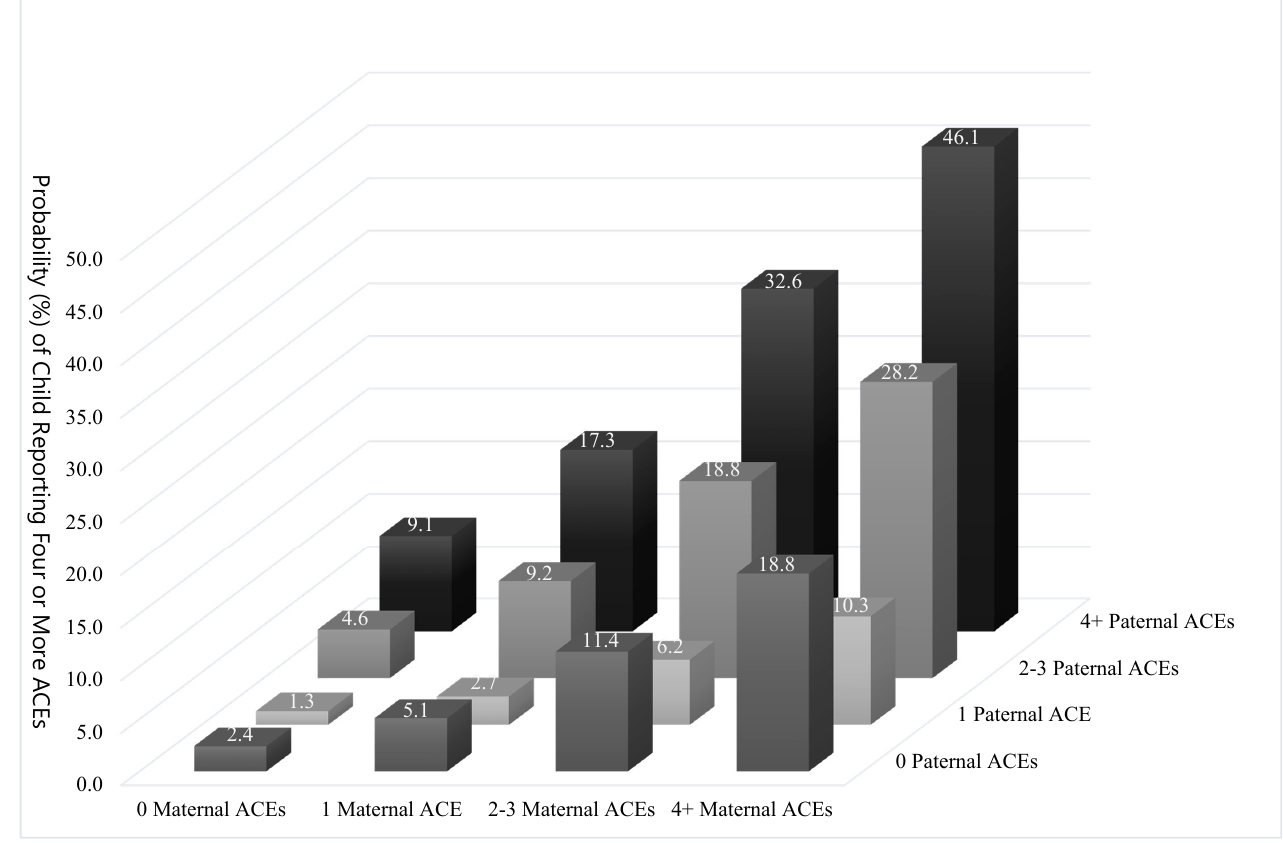
Figure 1. Risk of Four or More Child ACEs by Paternal and Maternal ACE Complement.